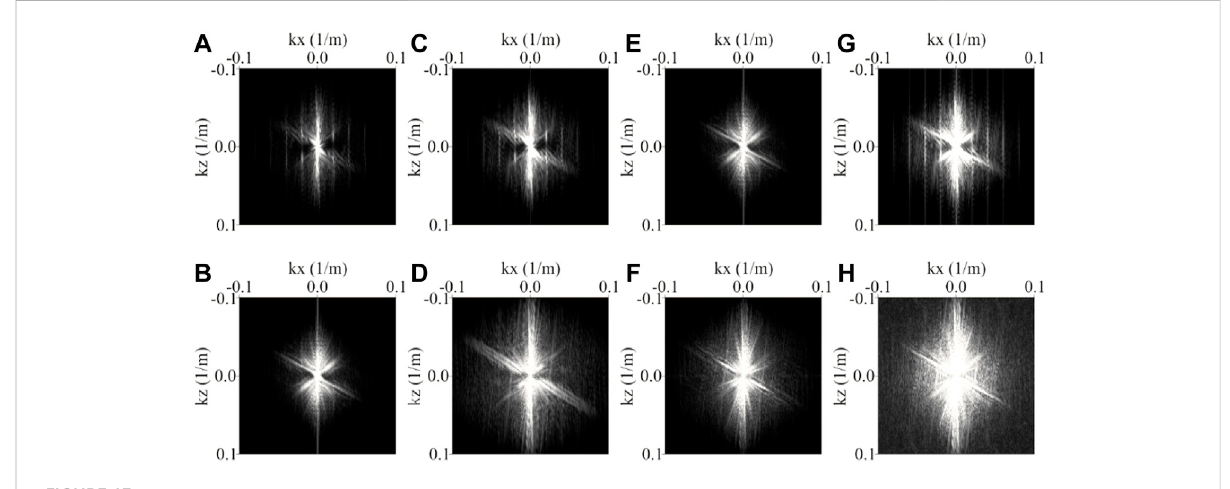
Wavenumber spectrum comparison of images shown in Figures 8, 9 for the Hess model. (A) RTM, (B) LSRTM, (C) viscoacoustic RTM, (D) viscoacoustic LSRTM, (E) VTI RTM, (F) VTI LSRTM, (G) viscoacoustic VTI RTM, and (H) viscoacousticVTI LSRTM. And the color scales of all the images are the same.